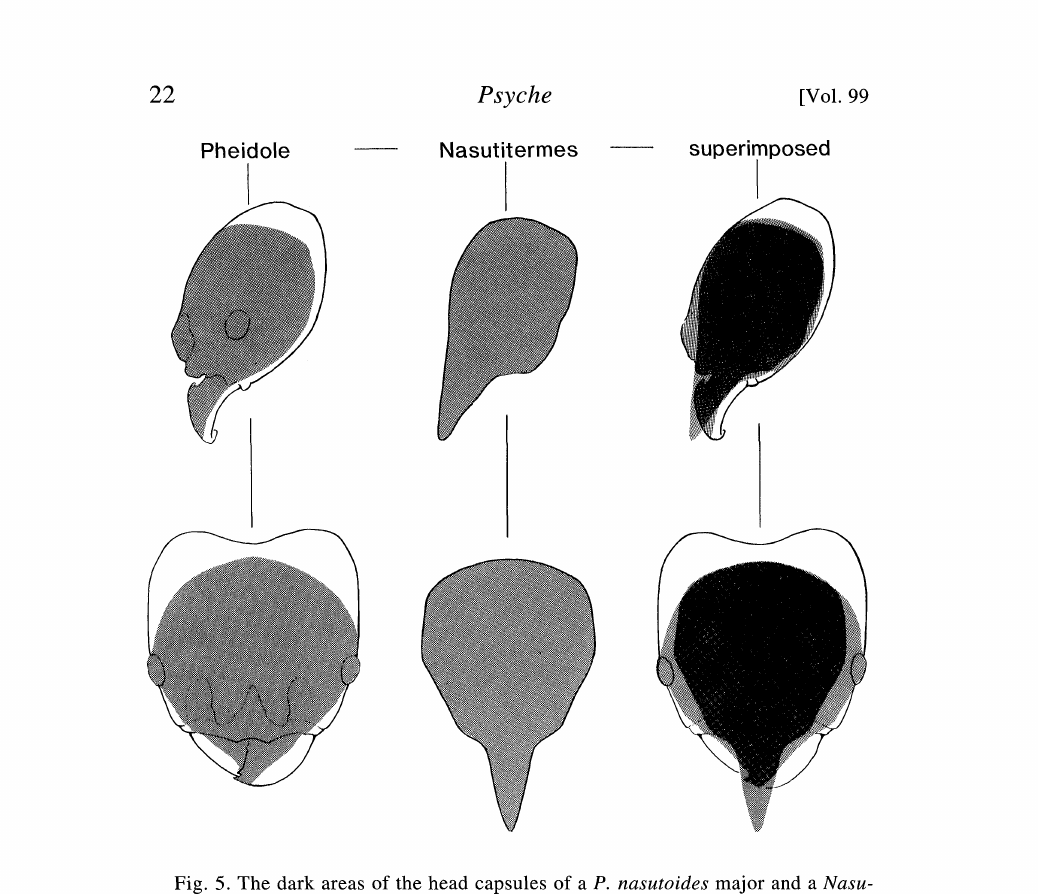
Fig. 5. The dark areas of the head capsules of a P. nasutoides major and a Nasu- titermes nasute soldier, depicted separately and